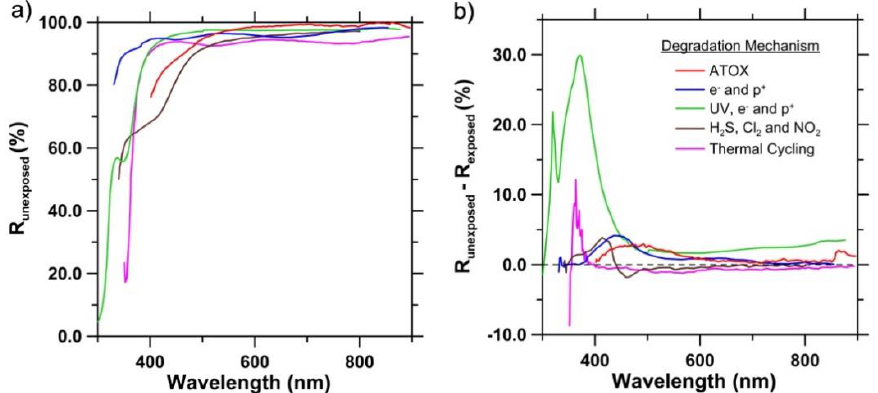
Figure 1. Overview of di ff erent degradation e ff ects on a silver mirror. ( a ) Reflectivity of protected Ag mirrors from several bibliographic sources, unexposed. The di ff erences in the mirror spectral performance are explained by the di ff erences in the composition and thickness of the protective coatings on the Ag layer. ( b ) E ff ect of several degradation mechanisms on the reflectivity of protected Ag mirrors. Red curve: degradation after 37 h of exposure to a 5eV AO beam (4 × 10 20 atom / cm 2 ) [34]. Blue curve: degradation after 279 h of simultaneous exposure to 10 keV electrons (5.3 × 10 15 e − / cm 2 ), 2 keV protons (3.5 × 10 14 p + / cm 2 ), and 5 keV protons (3.4 × 10 14 p + / cm 2 ) [35]. Green curve: degradation after 1436 h of simultaneous exposure to solar-equivalent UV, 10 keV electrons (1.4 × 10 18 e − / cm 2 ), and 5 keV protons (1.6 × 10 17 p + / cm 2 ). These dosage levels are equivalent to the radiation exposure at the L2 orbit location over a 5-year mission lifetime [36]. Brown curve: degradation after 240 h of simultaneous exposure to purified air mixed with Cl 2 (10 ppb), H 2 S (10 ppb), and NO 2 (200 ppb), at 30 ◦ C and a 70% relative humidity. These conditions are fairly similar to pre-launch environments [37]. Magenta curve: degradation after 30 thermal cycles from − 80 to + 35 ◦ C